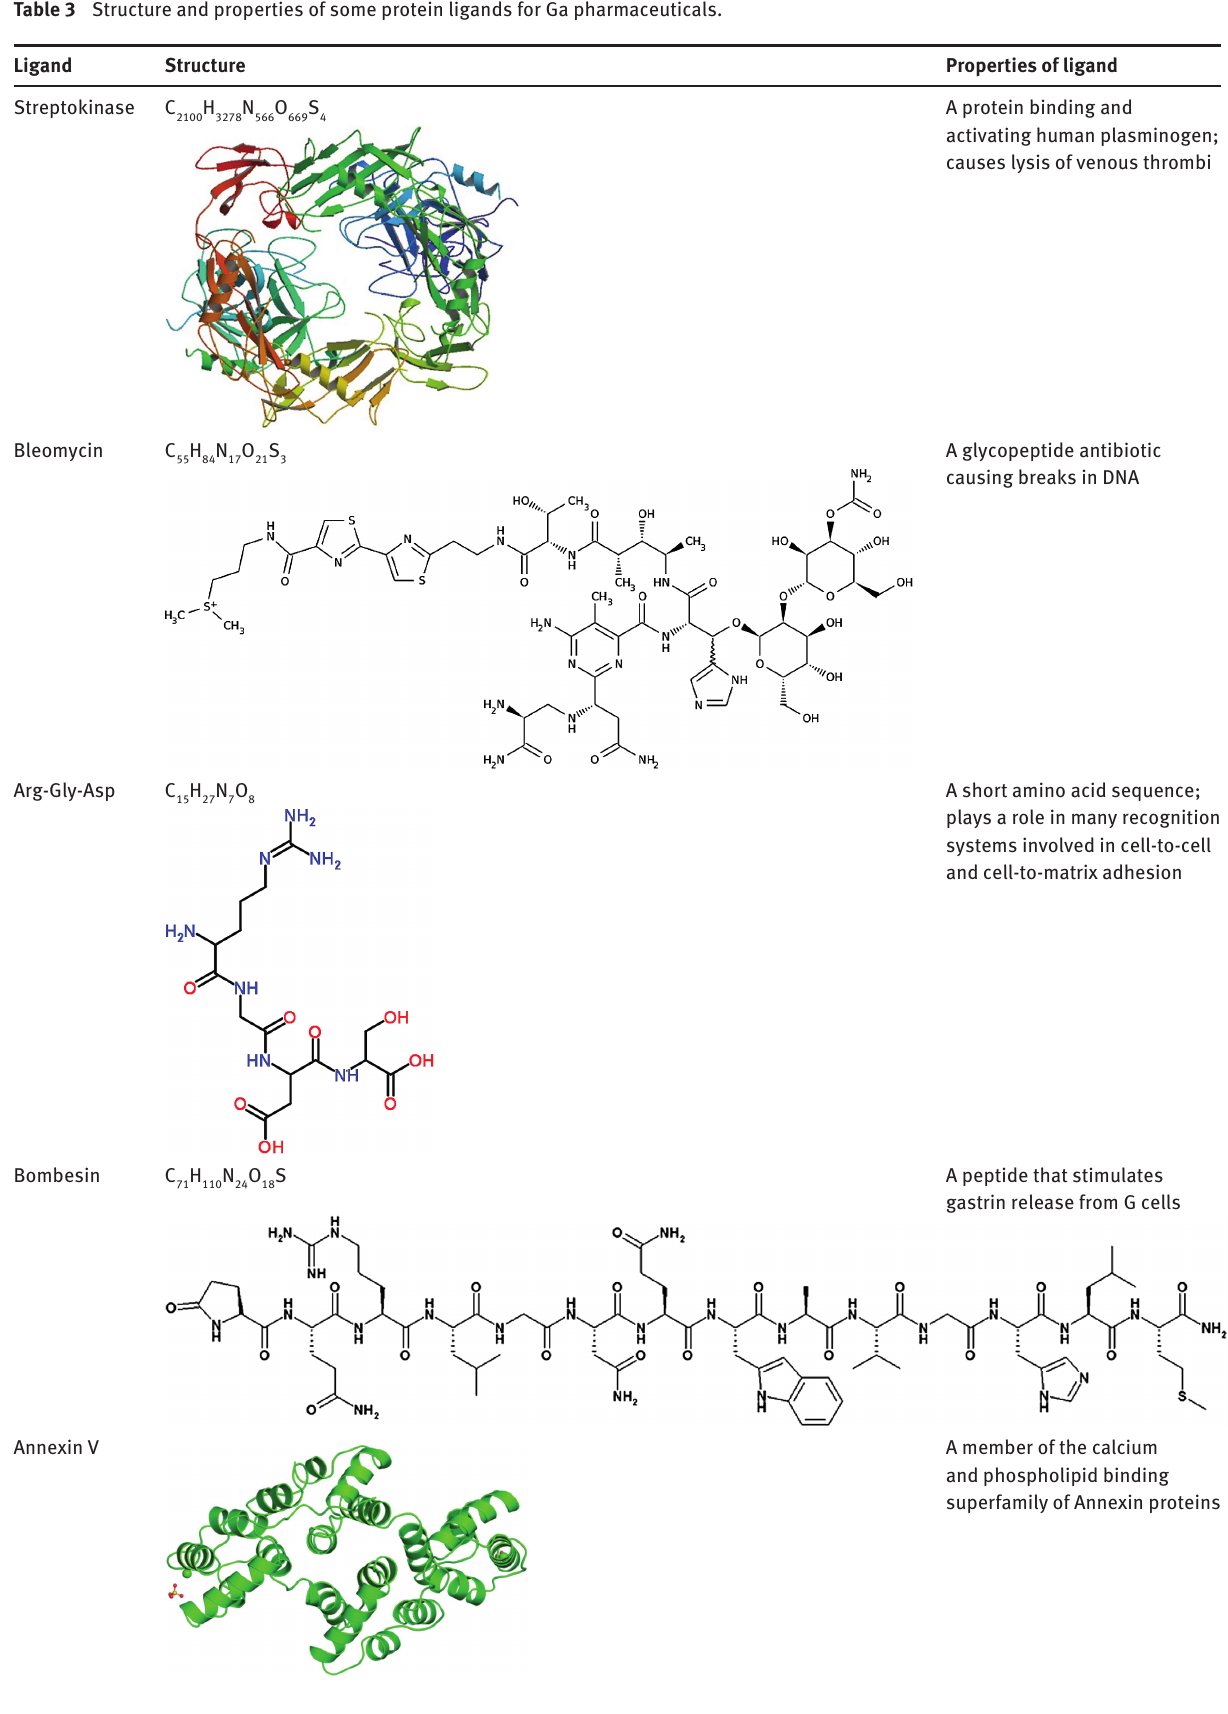
Table 3 Structure and properties of some protein ligands for Ga